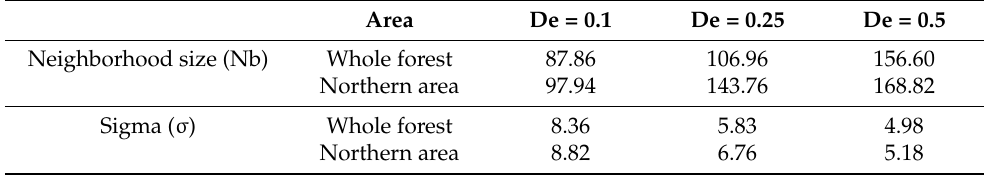
Table 2. Results for sigma depending on the effective density for the whole forest and the northern area. Area De = 0.1 De =